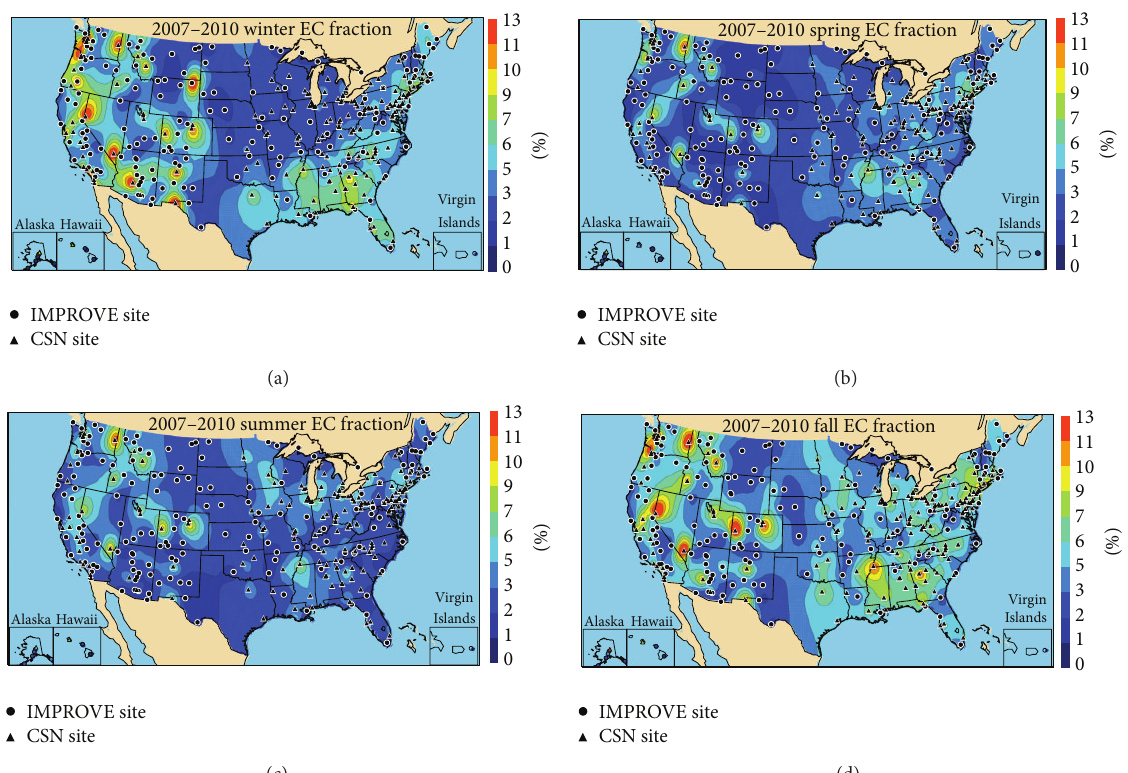
Figure 4: IMPROVE and CSN 2007–2010 seasonal mean PM 2.5 elemental carbon (EC) percent of reconstructed fine mass (RCFM) for (a) winter (DJF), (b) spring (MAM), (c) summer (JJA), and (d) fall (SON). IMPROVE sites are shown as circles, and CSN sites are shown as triangles.